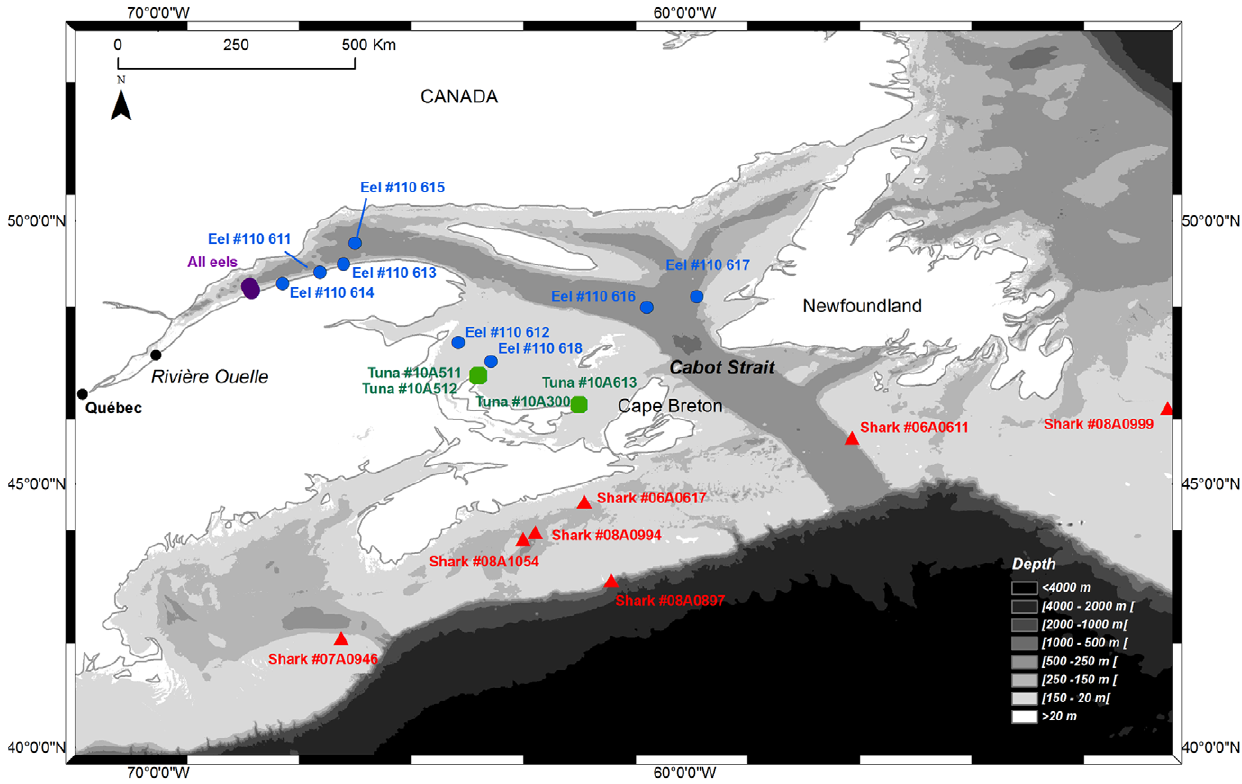
Figure 1. Map of the estuary and Gulf of St. Lawrence showing release site of eels (purple circles), sharks (red triangles) and tunas (green polygons) as well as location of first transmission of tagged eels (blue circles).